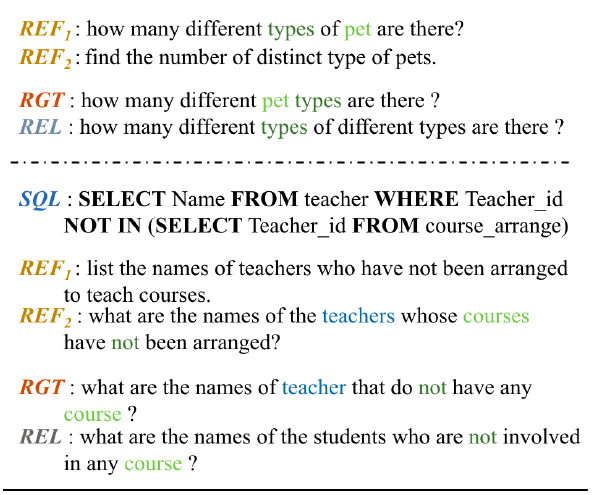
Figure 5. Case study: REF is the reference; REL is transformer with relative position; RGT is our